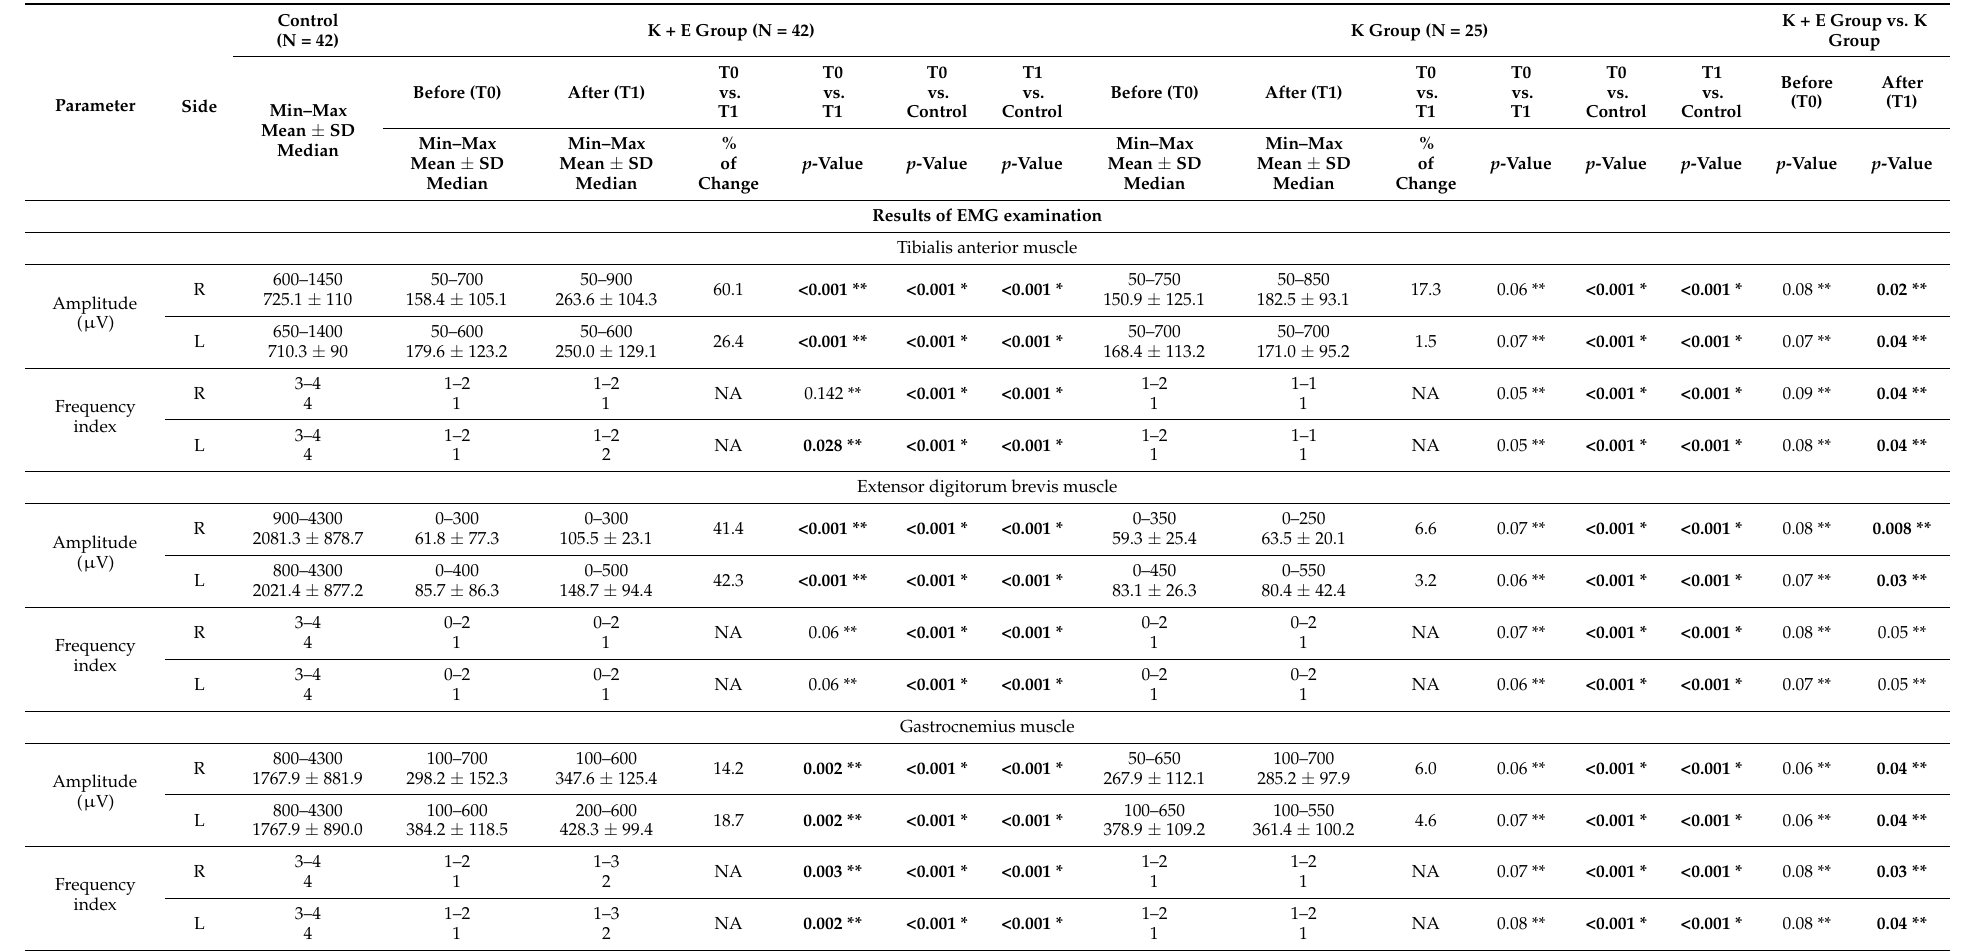
Table 2. Comparison of results from EMG and ENG recordings performed before and after electrotherapy in two groups of patients versus subjects from the control group of healthy